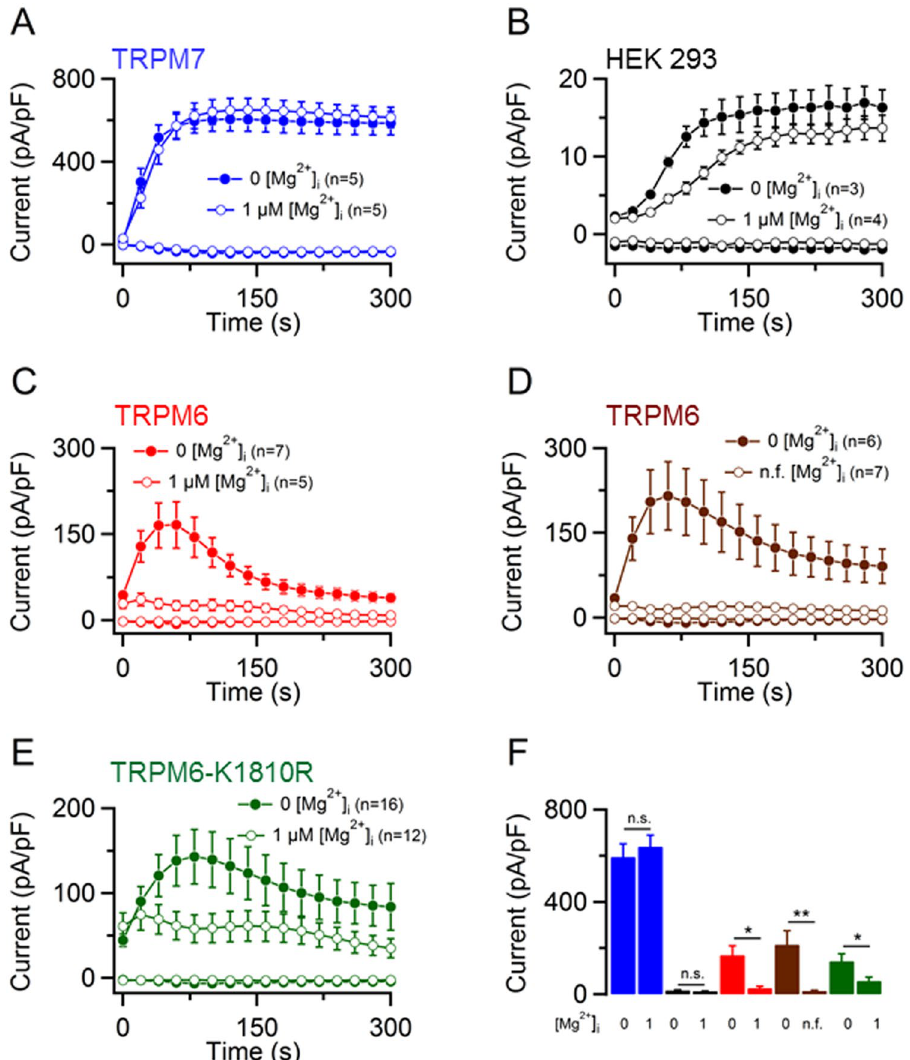
Figure 6. Effects of cytosolic Mg 2 + on mTRPM6 and mTRPM7 currents. Whole-cell currents (mean ± SEM) measured in mTRPM7-transfected HEK 293 cells ( A ), untransfected HEK 293 cells ( B ), or cells transfected either by wildtype mTRPM6 ( C , D ) or ‘kinase-dead’ mTRPM6-K1810R variant ( E ). In ( A – C and E ) cells were perfused either with a standard [Mg 2 + ] i -free intracellular solution or with a solution containing 1 µ M free [Mg 2 + ] i . In ( D ) measurements were performed with mTRPM6-transfected cells as in ( C ) except that a nominally [Mg 2 + ] i -free solution ( n . f .) was used. ( F ) Bar graphs of outward currents ( − 80 mV) shown in ( A – E ). Current amplitudes (mean ± SEM) were extracted at time intervals when the currents were maximally induced: at 200 s for mTRPM7 (blue) and untransfected cells (black), 50 s for wildtype mTRPM6 (red and brown), 80 s for mTRPM6-K1810R (green). n, number of cells measured; n.s., not significant; * P < 0.05; ** P < 0.01 (two-tailed